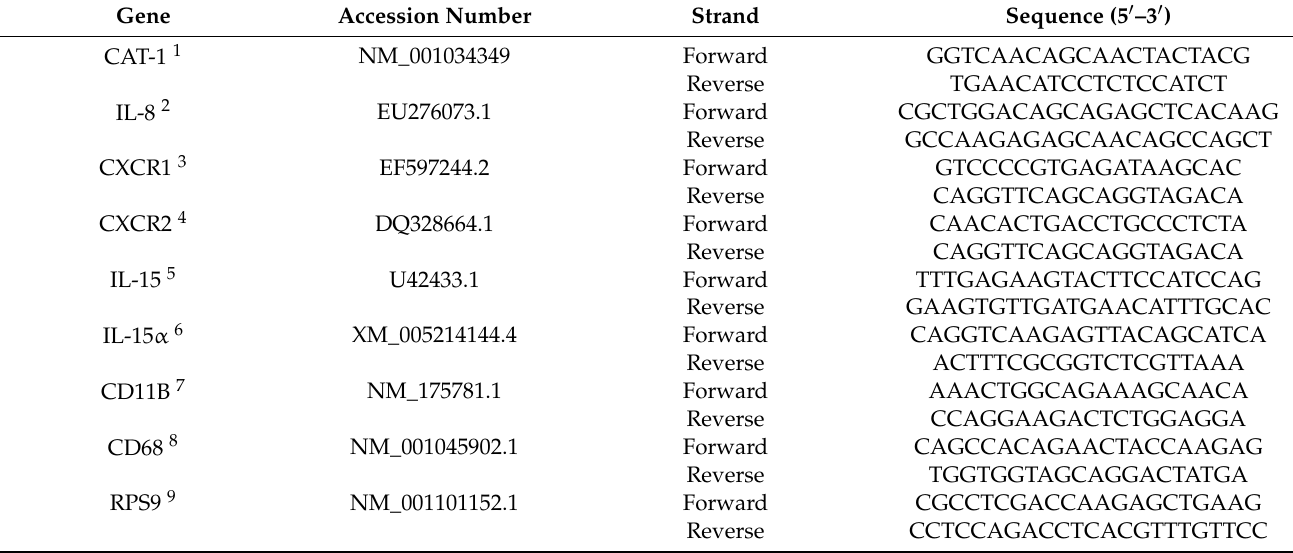
Table 2. Forward and reverse primers used for quantitative real-time